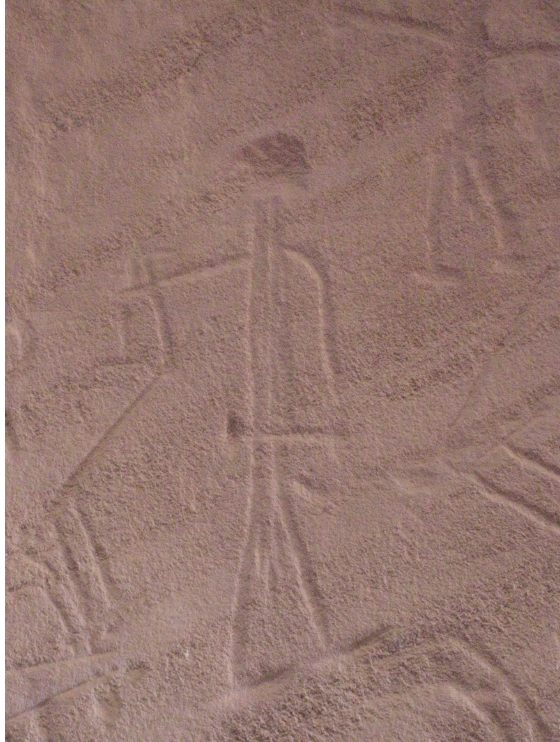
Figure 6 Rock engraving at Timna Mine 25: detail of human figures with weapons. Photo by the